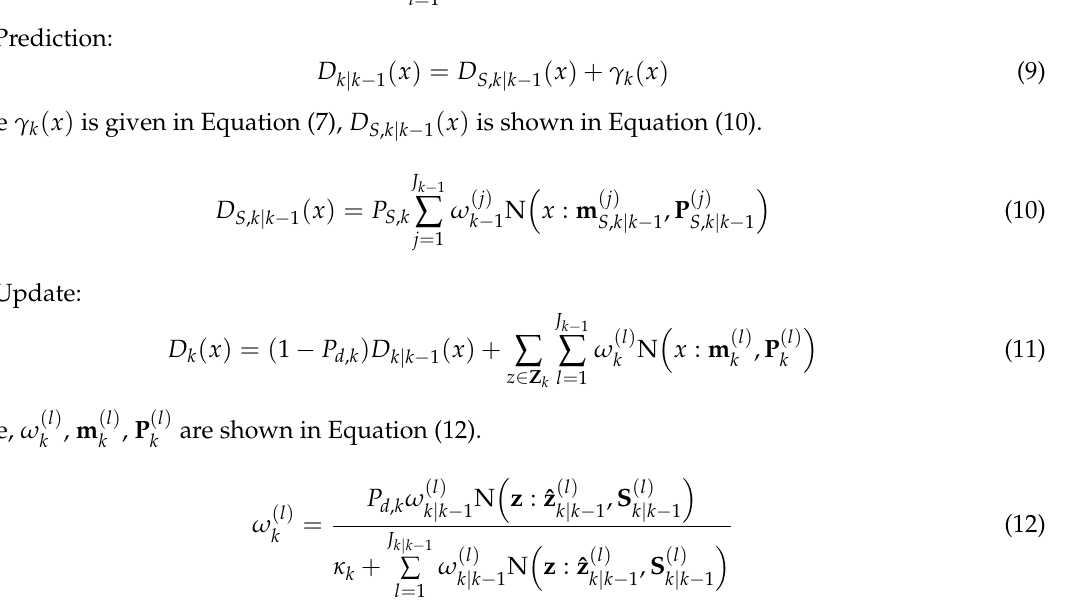
Figure 1. The space model of multi ‐ targets tracking.